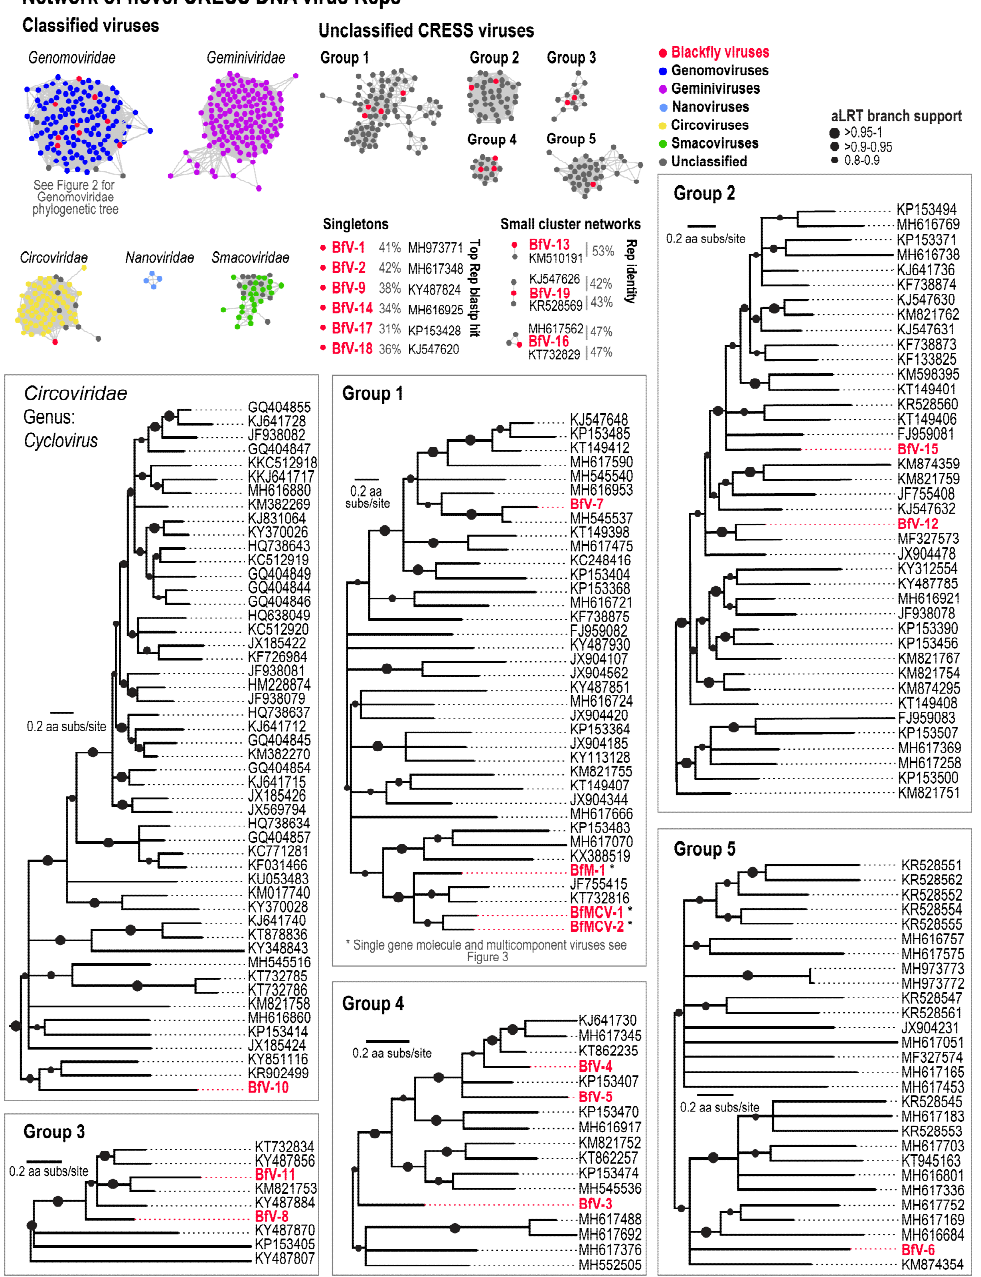
Figure 1. A network and phylogenetic analyses of the circular replication-associated (Rep) protein encoding single-stranded (CRESS) DNA virus replication-associated (Rep) protein sequences. The network analyses shows the clustering of the blackfly CRESS DNA viruses (shown as red circles) within taxonomic family groupings, larger and smaller groupings of unclassified CRESS DNA viruses (only those groups containing CRESS DNA viruses from this study), and singletons from this study that do not cluster with other known Reps. Closest Rep comparisons and percentage similarity are shown for the smaller groups and singletons. Maximum likelihood phylogenetic trees of the Rep sequence of circovirus (showing only the Cyclovirus genus clade) and the five larger unclassified CRESS DNA virus groupings. Blackfly originating sequence names are shown in red. The maximum likelihood phylogenetic tree of the Rep sequence for the genomoviruses is shown in Figure 2.